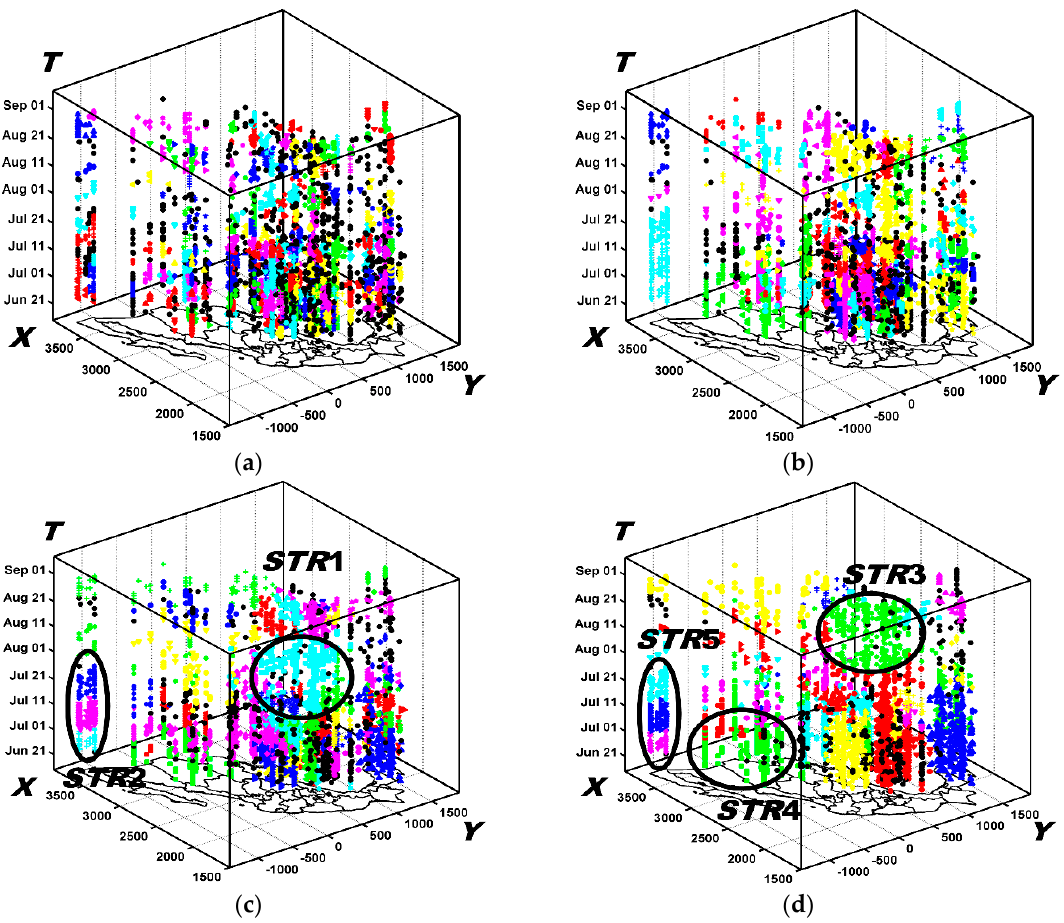
Figure 13. The spatio-temporal clusters discovered by STSNN. ( a ) k = 6, k T = 3, MinPts = 3, Δ T = 2; ( b ) k = 10, k T = 5, MinPts = 5, Δ T = 2; ( c ) k = 16, k T = 8, MinPts = 8, Δ T = 2; ( d ) k = 20, k T = 10, MinPts = 10, Δ T = 2.